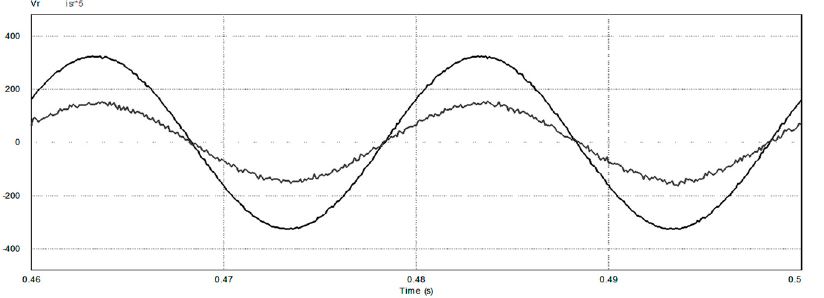
Figure 16. Caso D—voltage and current in phase R . Figure 16. Caso D - voltage and current in phase R .